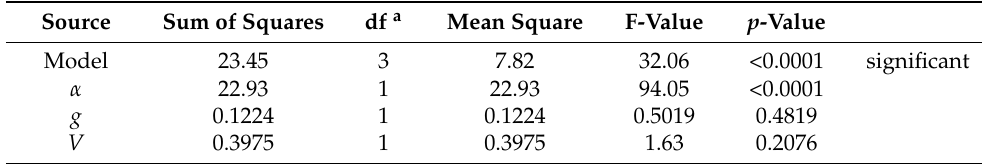
Table 4. ANOVA results. Dependent variable—ultimate shear stress — τ (MPa).